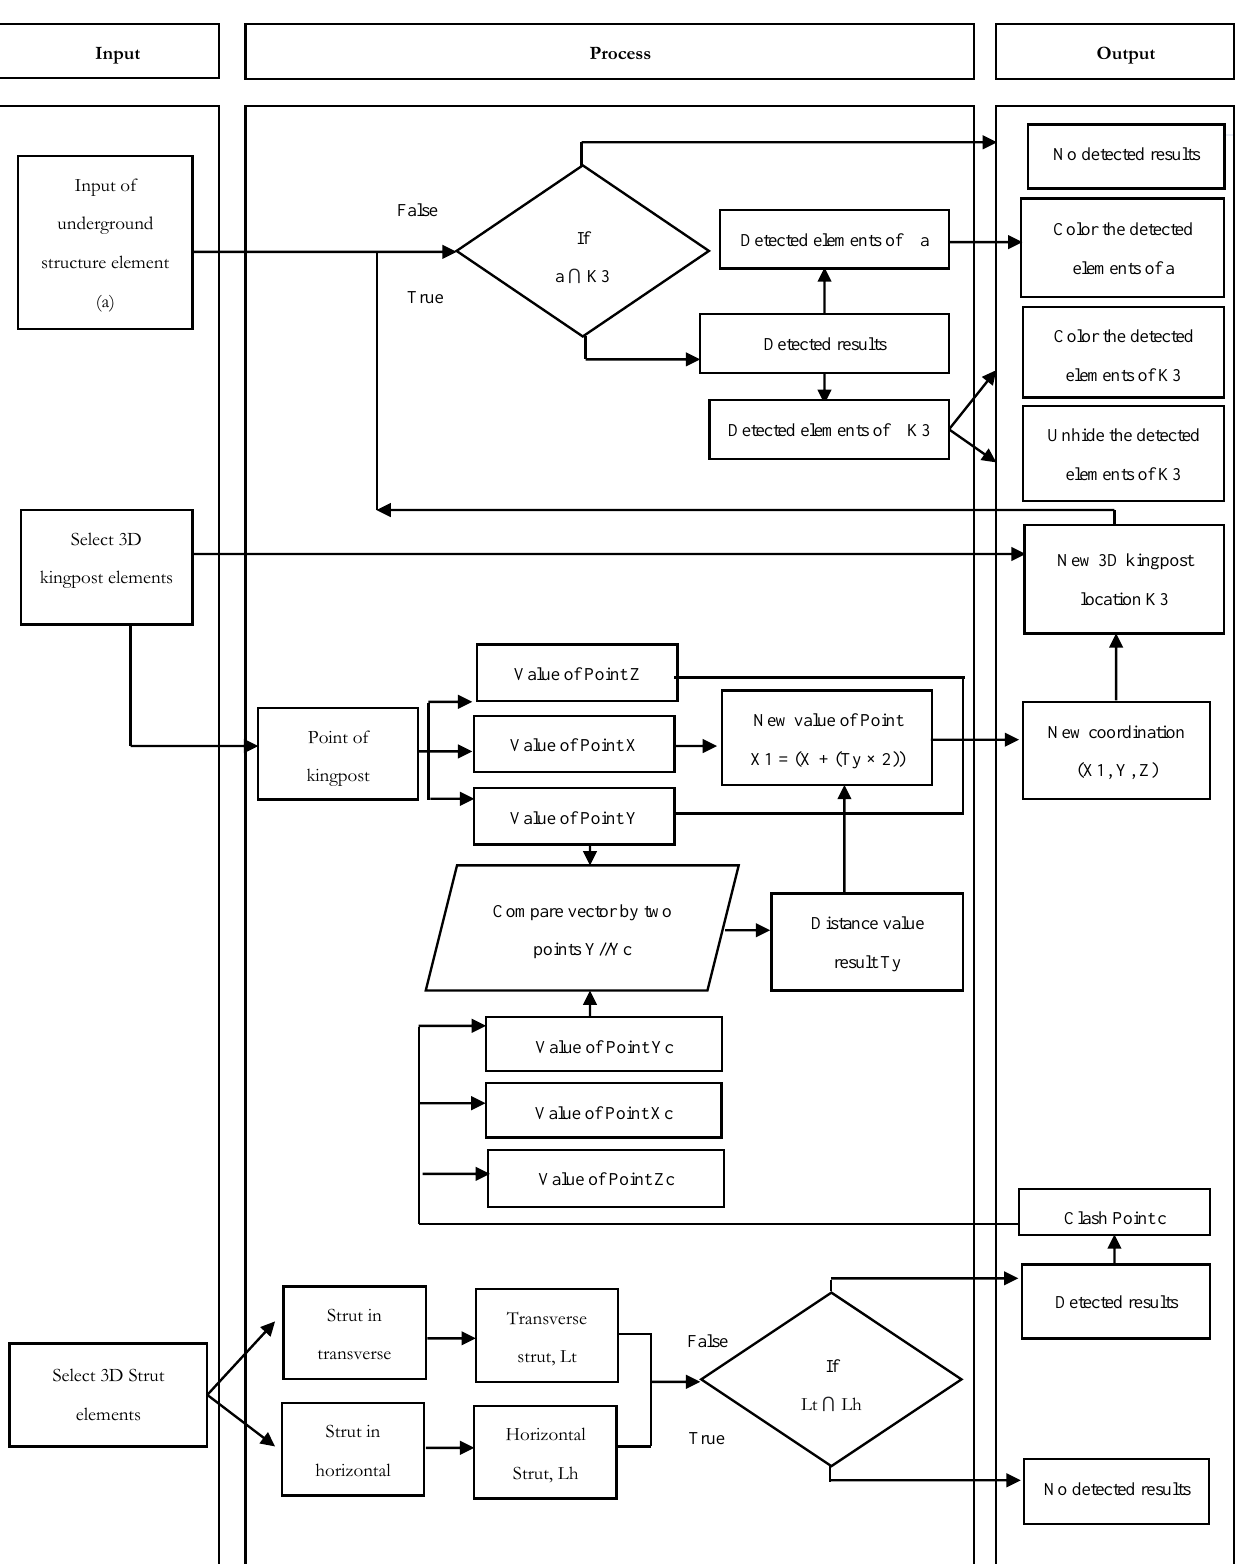
Figure 15. A module of kingpost relocation to the third location.